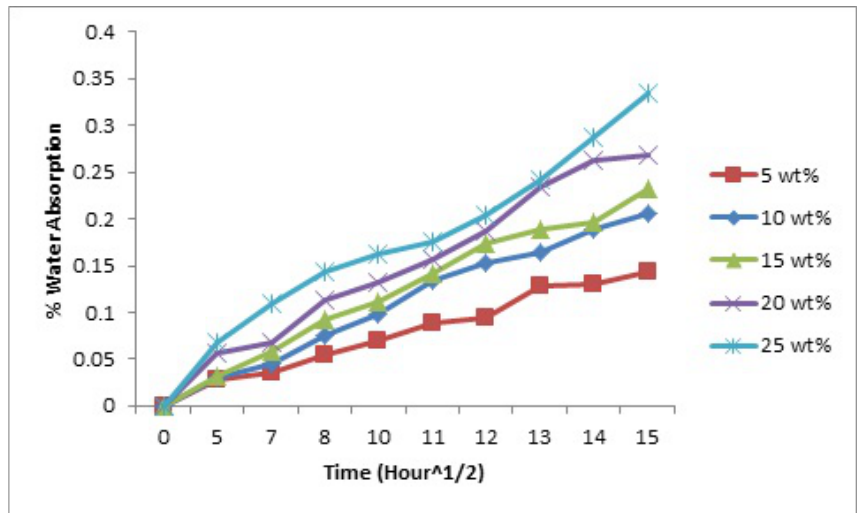
Figure 12: Water absorption versus square root of hours